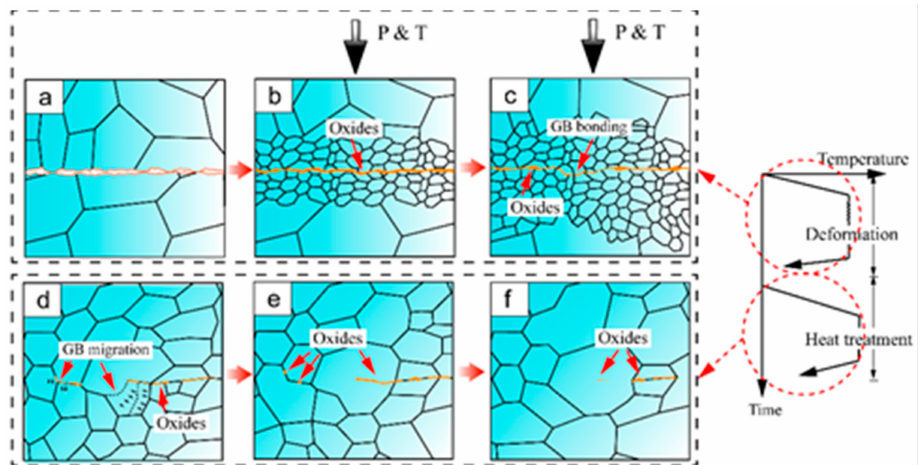
Figure 7. Schematic illustration of the interface bonding